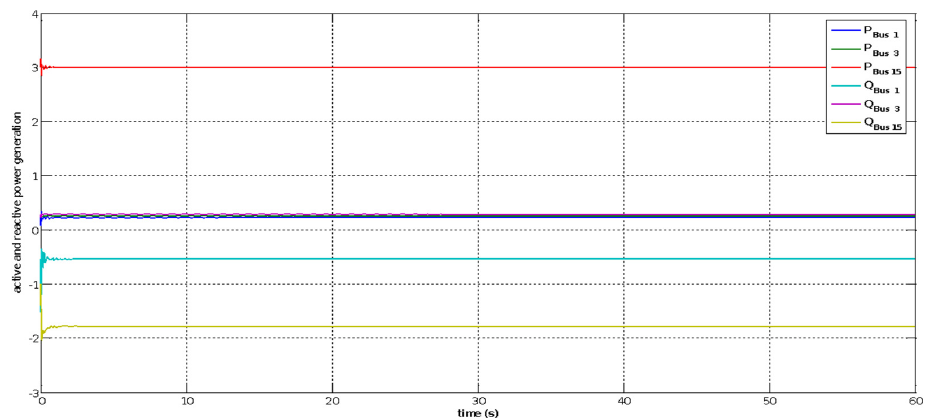
Figure 29. Voltage variation at all buses during the base case.